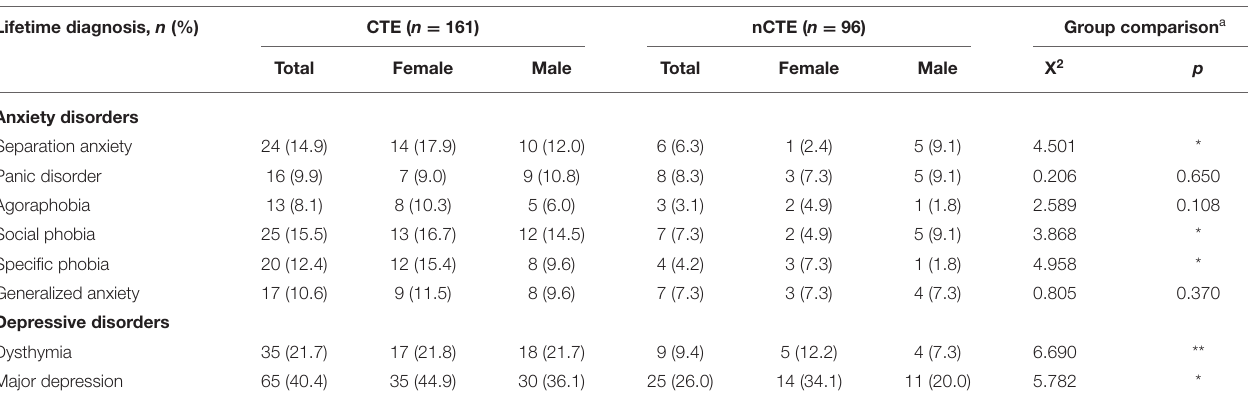
TABLE 4 | Lifetime internalizing mental health disorders (diagnosis) and group comparisons. Lifetime diagnosis, n (%)